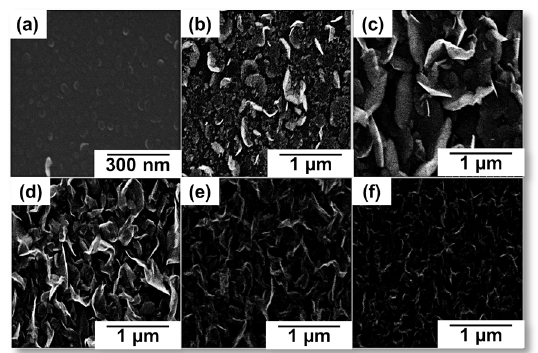
Figure 10. SEM images of the CNWs according to the following growth temperatures: ( a ) 700 °C, ( b ) 750 °C, ( c ) 800 °C, ( d ) 850 °C, ( e ) 900 °C, and ( f ) 950 °C. Reproduced with permission from [98]. Copyright Elsevier 2014.